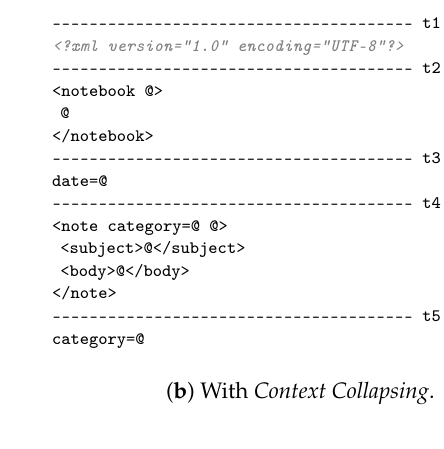
Figure 5. Notebook XML Schema document.